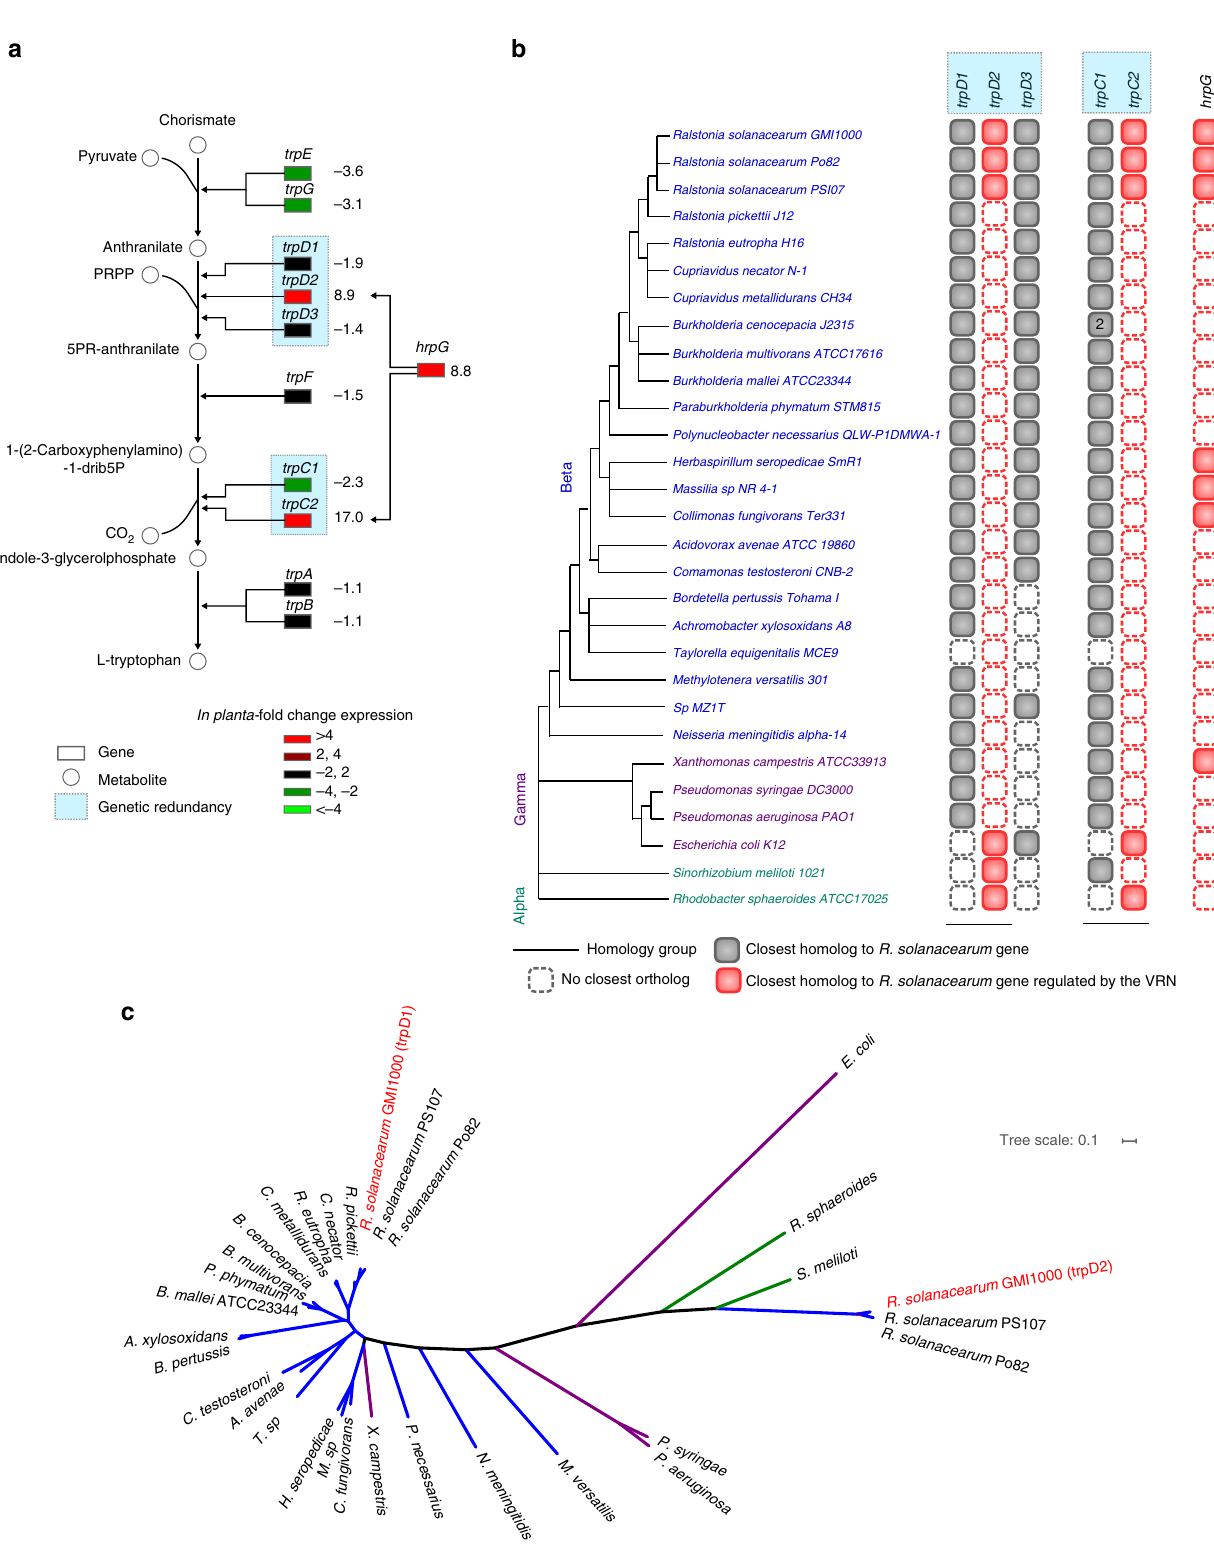
Fig. 6 Orthology analysis of VRN-regulated and VRN-independent genes contributing to robustness within the tryptophan biosynthesis pathways. a The R . solanacearum tryptophan biosynthesis pathway and the corresponding in planta gene expression pro fi les. The values correspond to the absolute fold change expression levels (from Jacobs et al. 50 ). b Presence of homologs of the R . solanacearum genes in the various taxa is displayed by boxes. Number in the boxes corresponds to the number of paralogs present in the organism. Closest homologs to a VRN-regulated gene are colored in red, whereas the closest homologs of a VRN-independent one are in gray. In the case of two genes belonging to the same homology group, the closest homolog to a R . solanacearum gene was de fi ned as the gene showing the highest blast score to a R . solanacearum gene. c Phylogeny analysis of the trpD1 and trpD2 homolog groups. Tree scale corresponds to 0.1